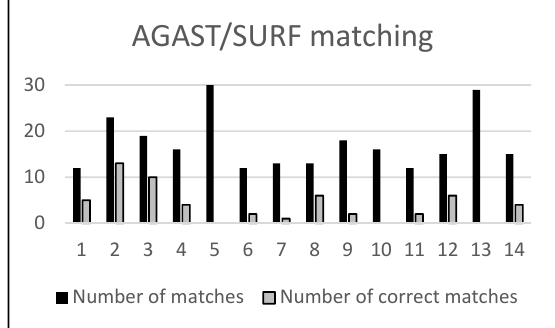
Figure 4. Matching results of AGAST detection and SURF description across all 14 tiles